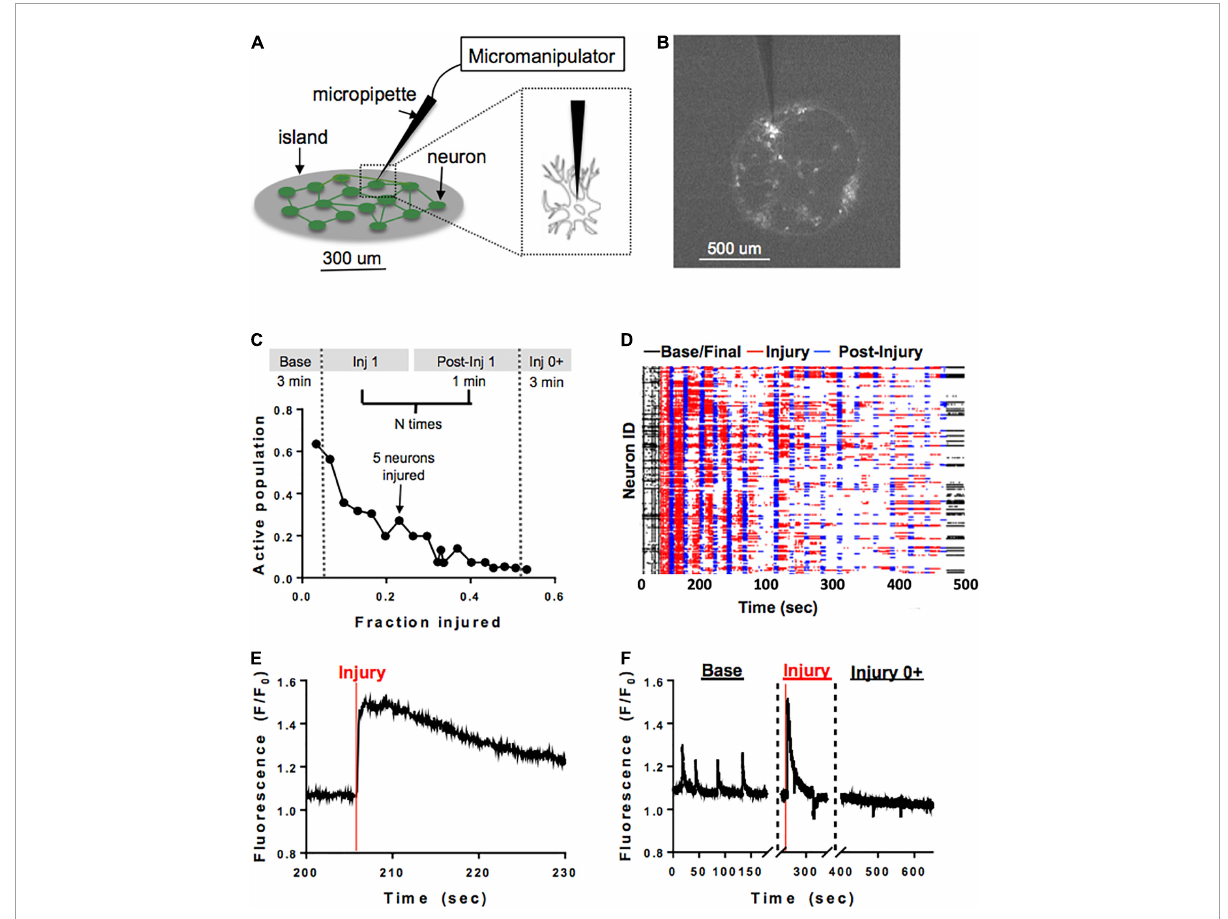
FIGURE2 Microablation injury model. Schematic of microablation injury. (A) A micropipette tip (5–10 um diameter) attached to a FemtoJet device was momentarily brought into contact with individual neurons at a 90-degree angle. The individual neurons were physically impacted with the micropipette, leading to a transient mechanoporation of the cell and permanent deactivation. (B) Example of a small island under × 4 magnification. Each white dot represents a cell expressing GCaMP6f stimulated with 488 nm laser light. (C) Schematic of sequential injury protocol, where five neurons were chosen for microablation during each injury period, up to a total of 75% of an island’s population. (D) Ca 2 + recordings from an island undergoing a sequential injury of 5 neurons at a time (red bands) and post-injury (blue bands) periods, in addition to an initial and final spontaneous activity recording (black bands). Partially synchronous spontaneous activity (black, left) was gradually reduced, and synchrony was lost in post-injury intervals (blue) as the level of injury was increased until activity was silenced by visual inspection. Few cells were still active in the final post-injury recording (black, right). (E,F) Zoom in on injury in a single neuron. The initial regular spontaneous Ca 2 + activity in a neuron is interrupted by a large increase in intracellular Ca 2 + as the micropipette is brought into contact with the cell, likely corresponding to transient mechanoporation, (E) followed by permanent inactivation in the subsequent recording session (F)